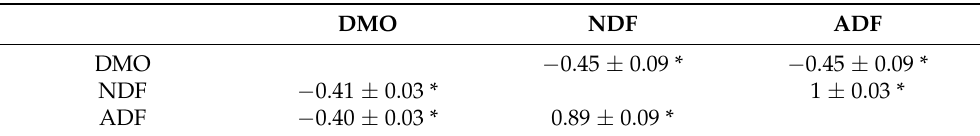
Table 3. Genotypic (above diagonal) and phenotypic (below diagonal) correlation coefficient esti- mates for cell wall